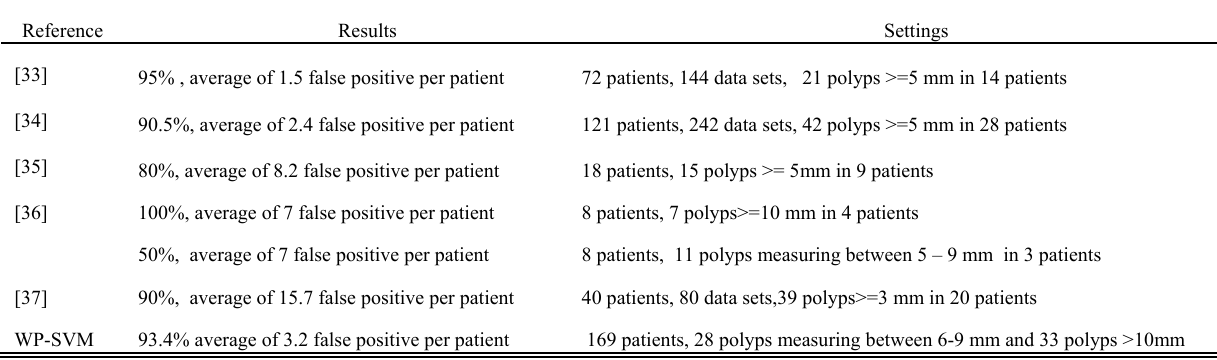
Table 5. Binary and Offline CAD Results as Reported in Literature Compared with